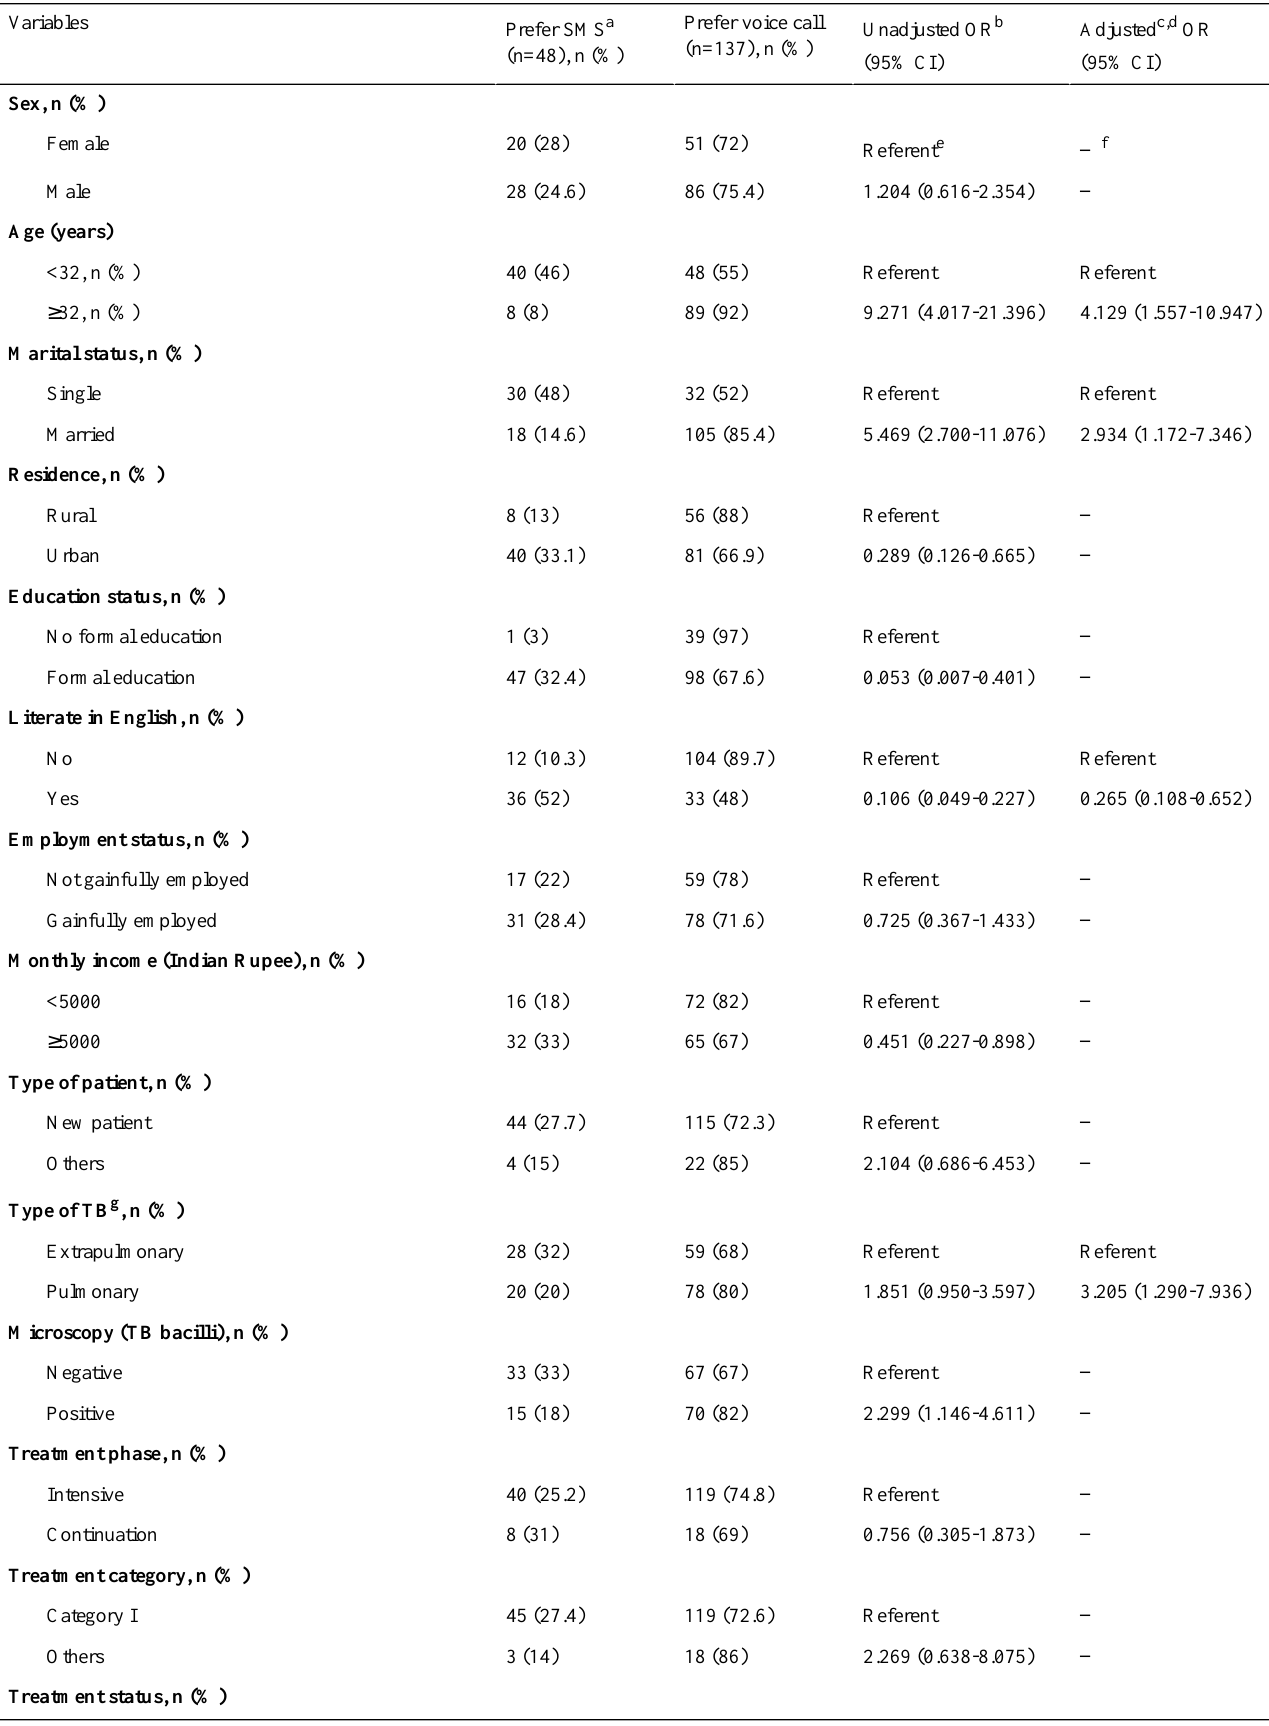
Table 4. Preference for an intervention and its association with clinical and demographic characteristics